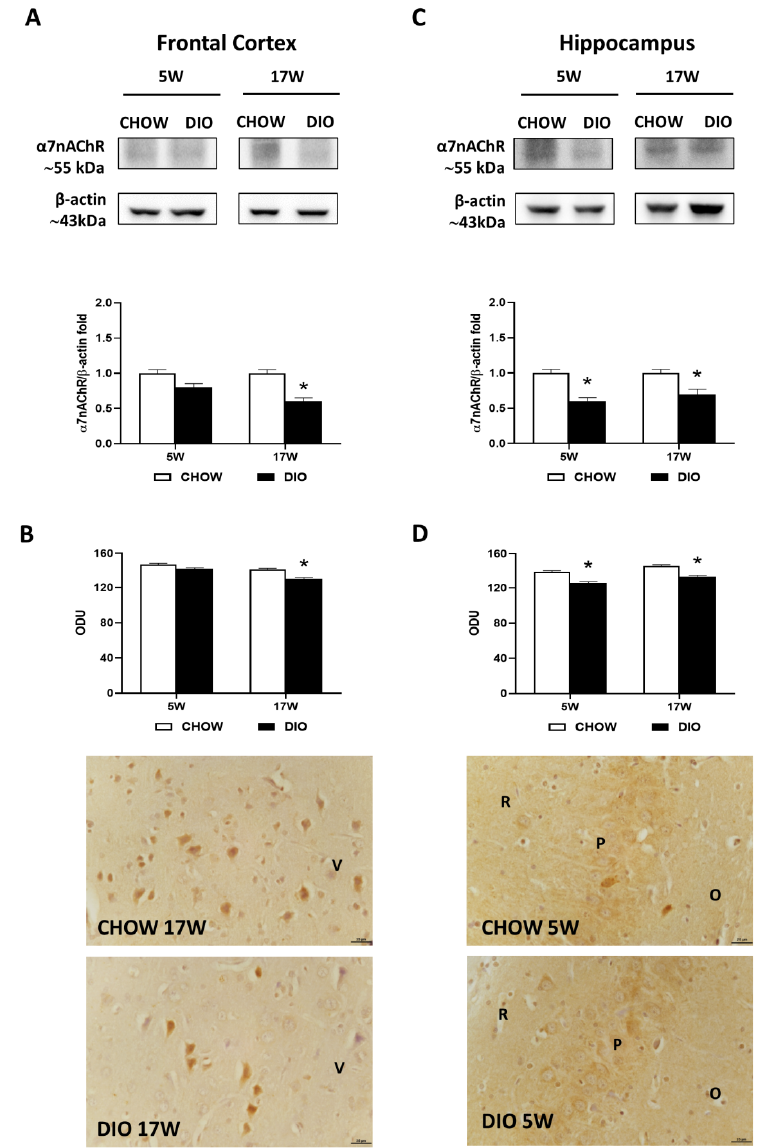
Figure 4. Western blot and immunohistochemistry of alpha7 nicotinic acetylcholine receptor ( α 7nAChR). Samples of the frontal cortex ( A ) and hippocampus ( C ) from rats fed with a standard diet